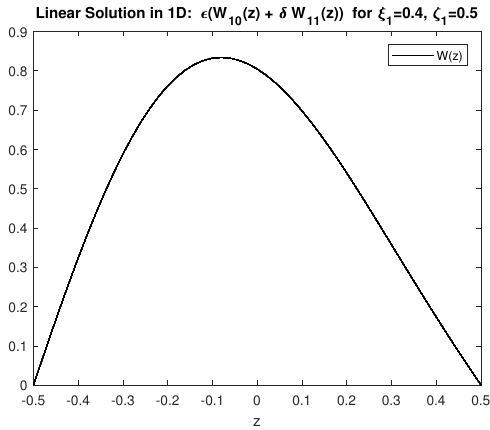
Figure 6. Linear 1D solution for W , i.e., (cid:101) ( W 10 ( z ) + δ W 11 ( z ))